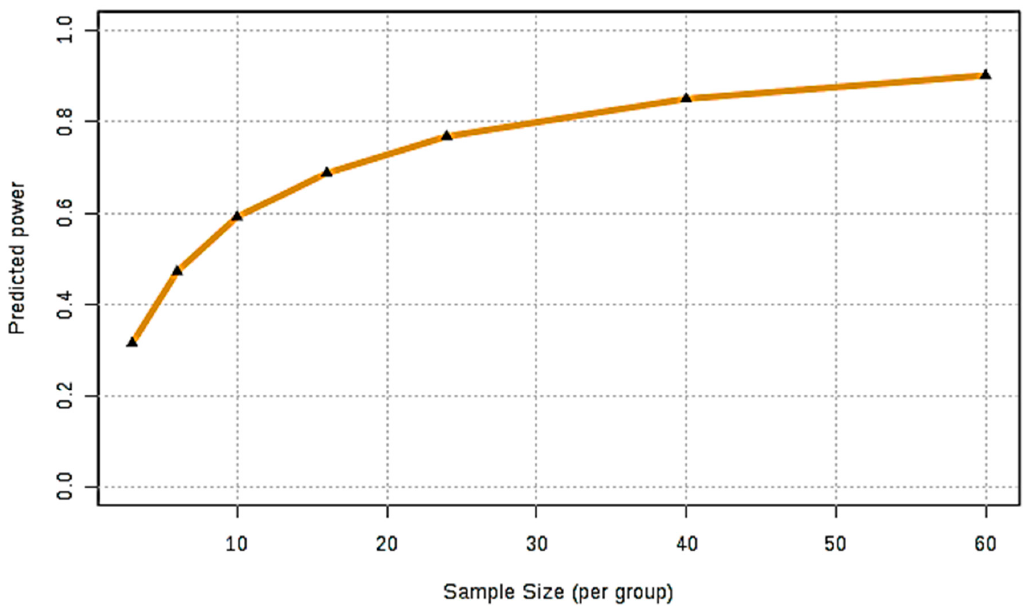
Figure 5. Power analysis of GM1 Type II and controls. Predicted power curve for our pilot GM1 type II disease 1 H NMR profile dataset containing n = 28 healthy controls and only 9 with this LSD. The FDR p value for this power calculation was pre-set at a value of 0.05, and normalisation, transformation and scaling were performed as described in Figure 3 legend.